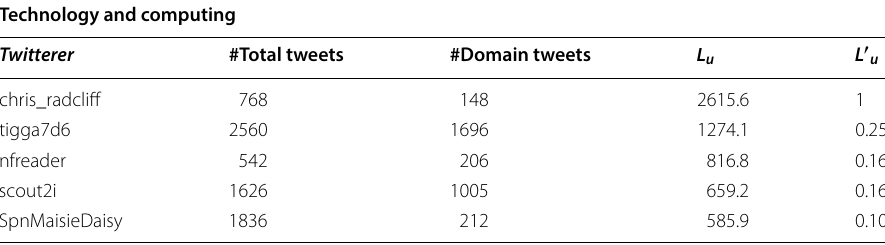
Table 3 Domain-based user likes L u,d